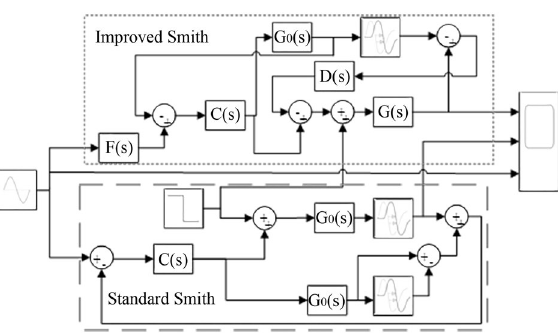
Figure 16. Improved Smith and standard Smith predictive control model diagram.